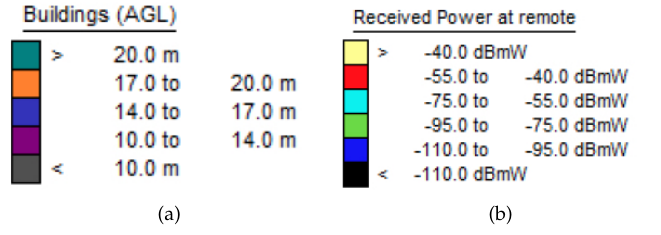
Figure 9. Colour range: ( a ) building height; ( b ) received power at remote